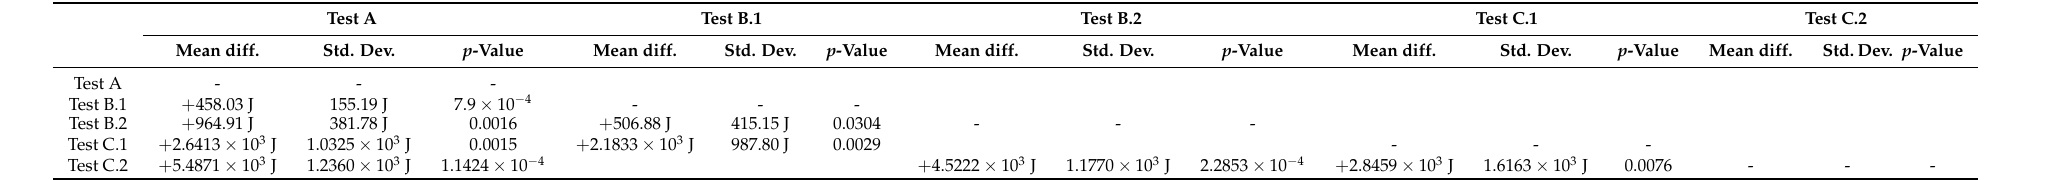
Table A2. Comparison of the results between the different cases